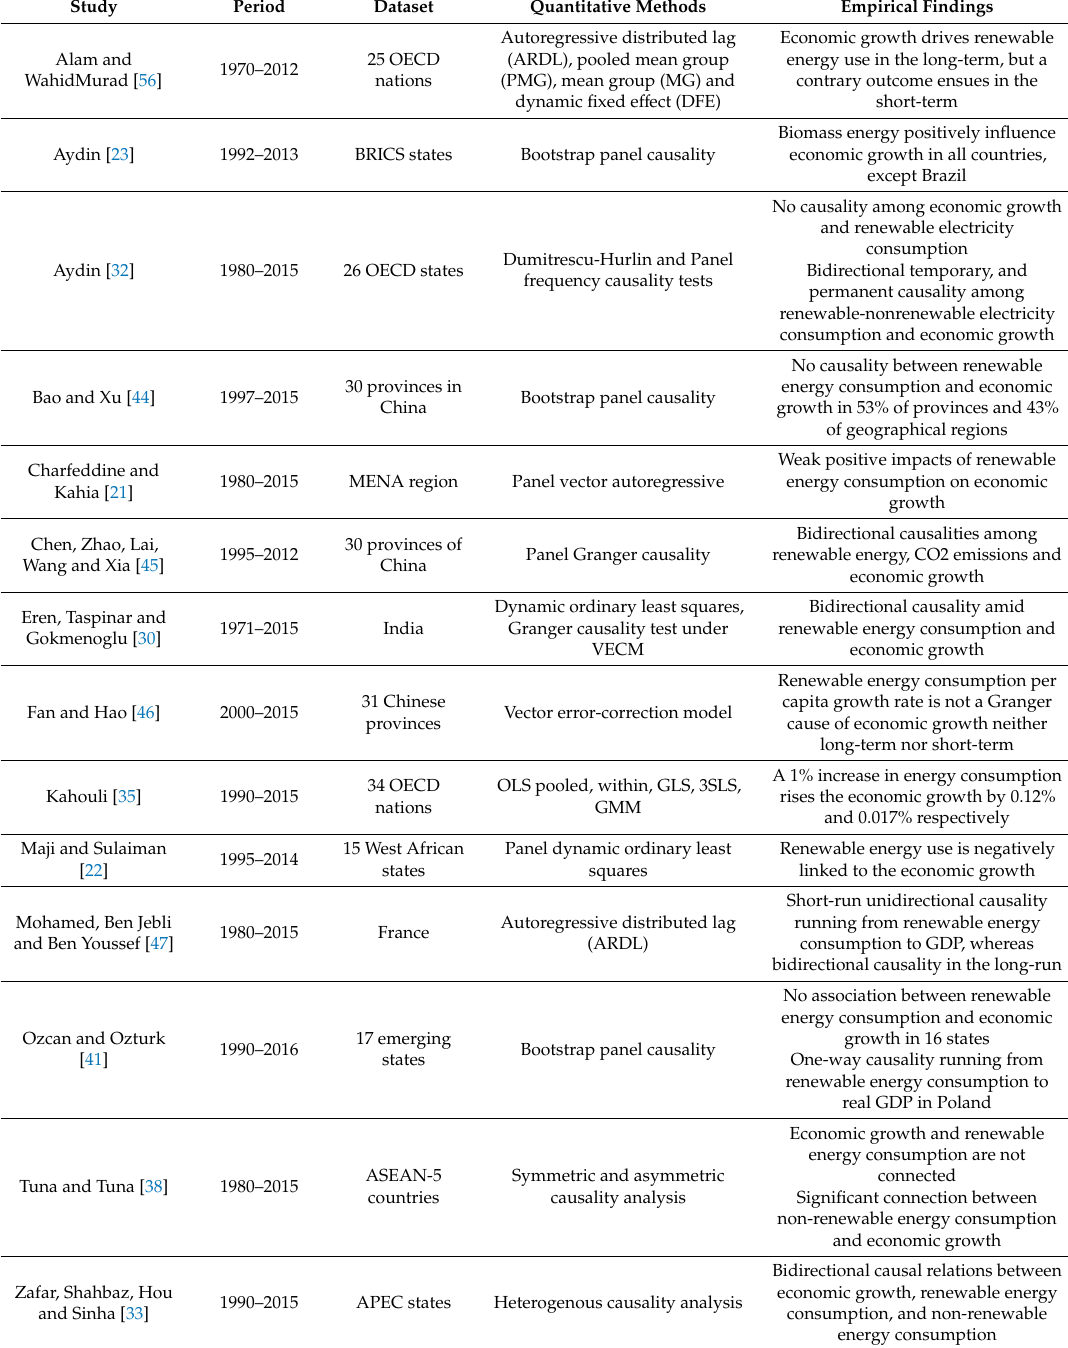
Table 1. Summary of previous related